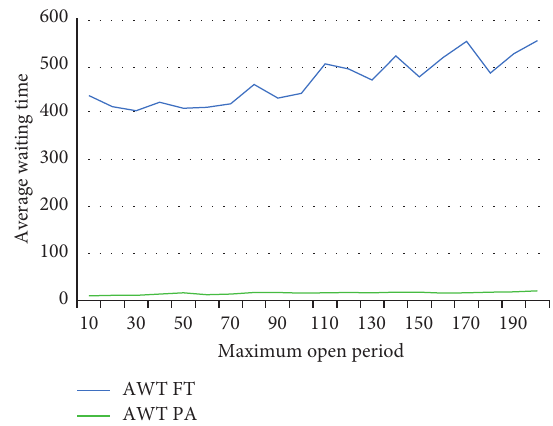
Figure 15: Effect of changing the maximum open period, ( T or the fixed green period in the FT algorithm on the number of serviced vehicles using the OA, FT, and PA algorithms.